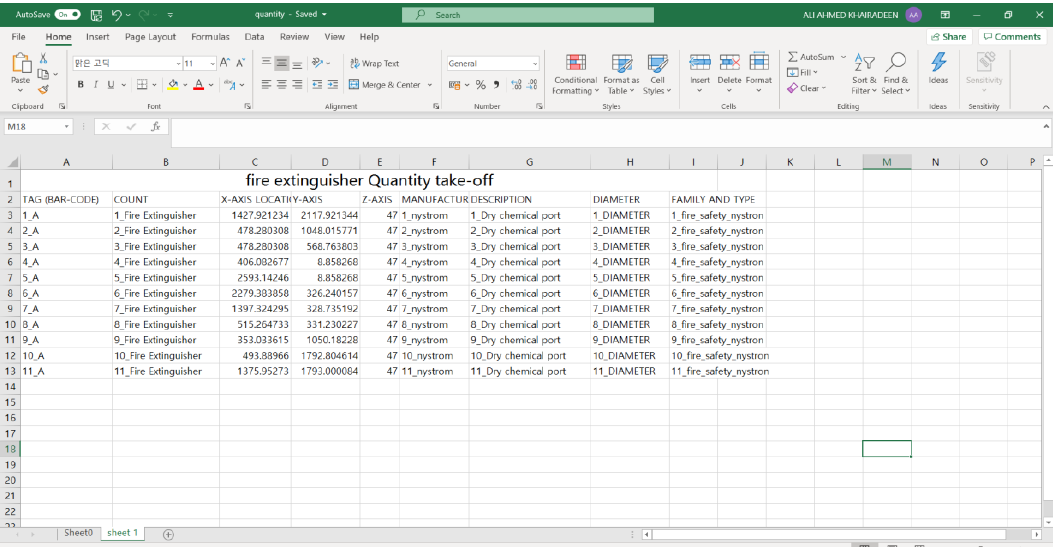
Figure 8. Heatmap of the con-fire safety planning Simulation.